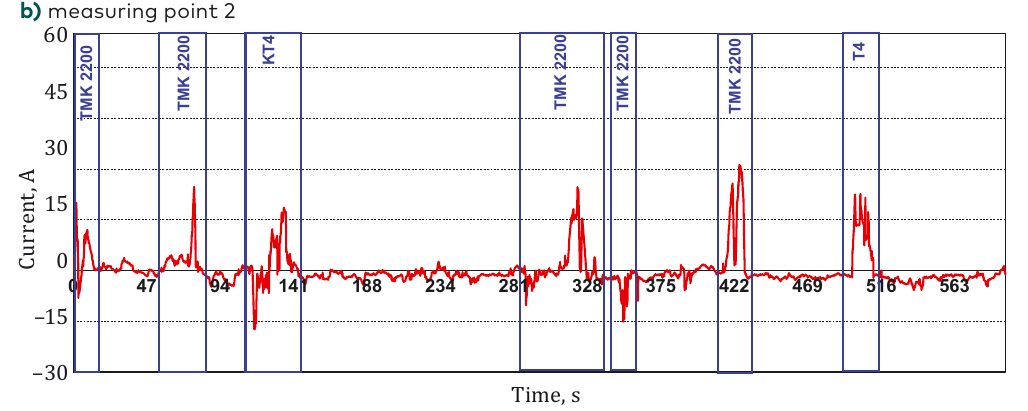
Figure 7. Results of stray current field measurement in two measuring points, with marked tram